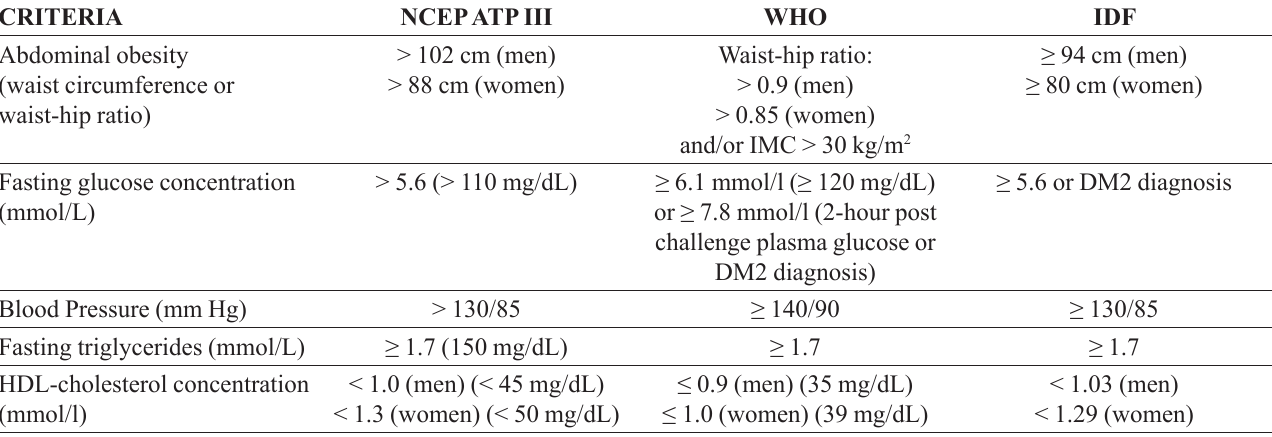
TABLE I - Criteria for the diagnosis of metabolic syndrome CRITERIA NCEP ATP III WHO IDF Abdominal obesity > 102 cm (men) Waist-hip ratio: (waist circumference or waist-hip ratio) Fasting glucose concentration